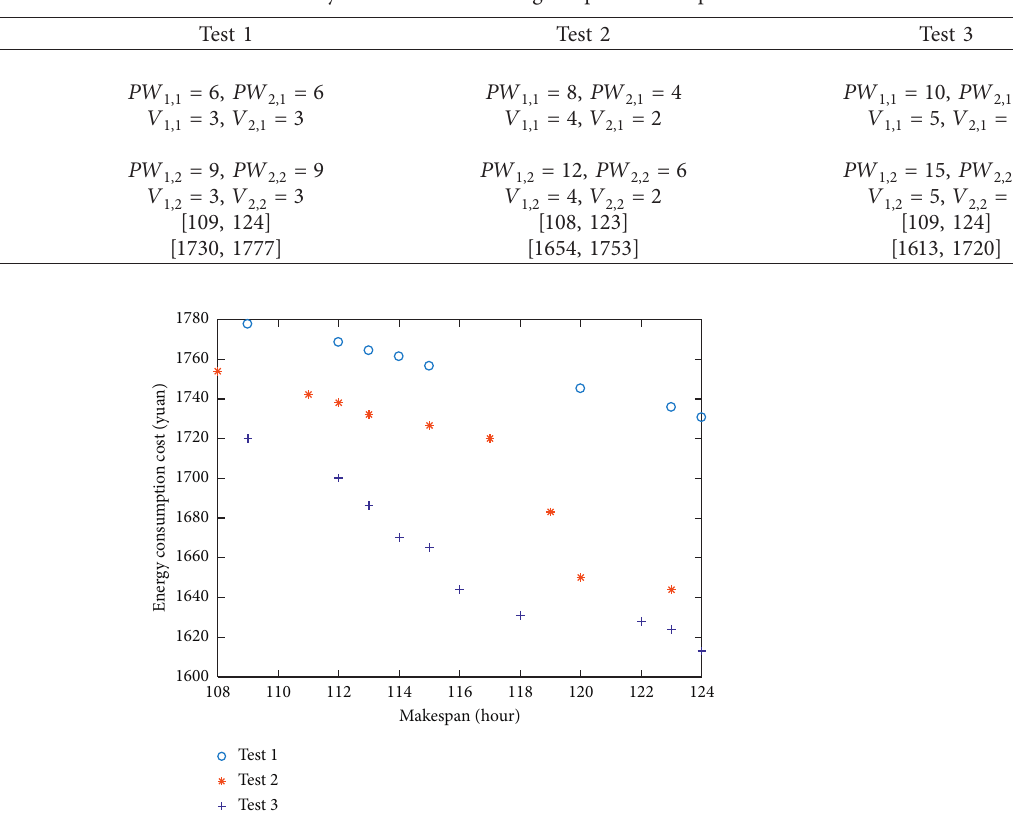
Figure 16: Pareto fronts by different settings of speed and power.